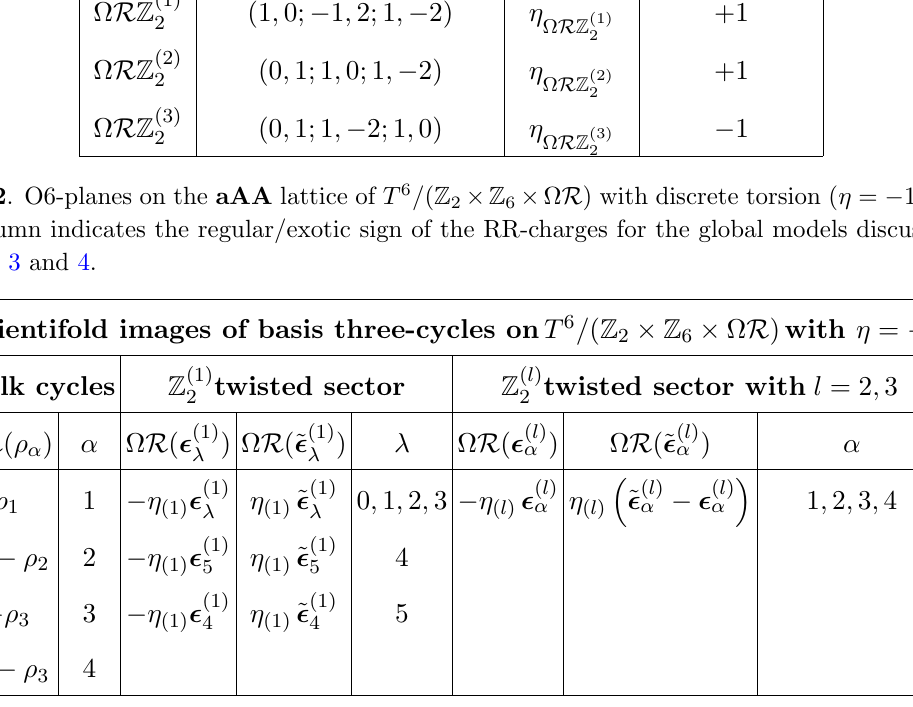
Table 3 . Orientifold images of the basis bulk and Z ( k )